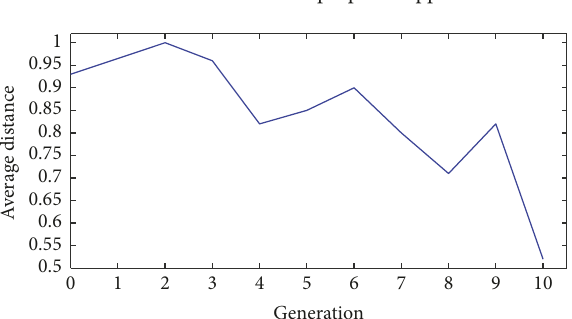
Figure 13: Fitness value of proposed approach.